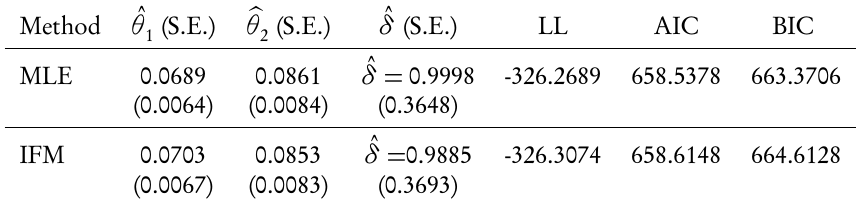
. Figure 8 – K-S plot for data set X 1